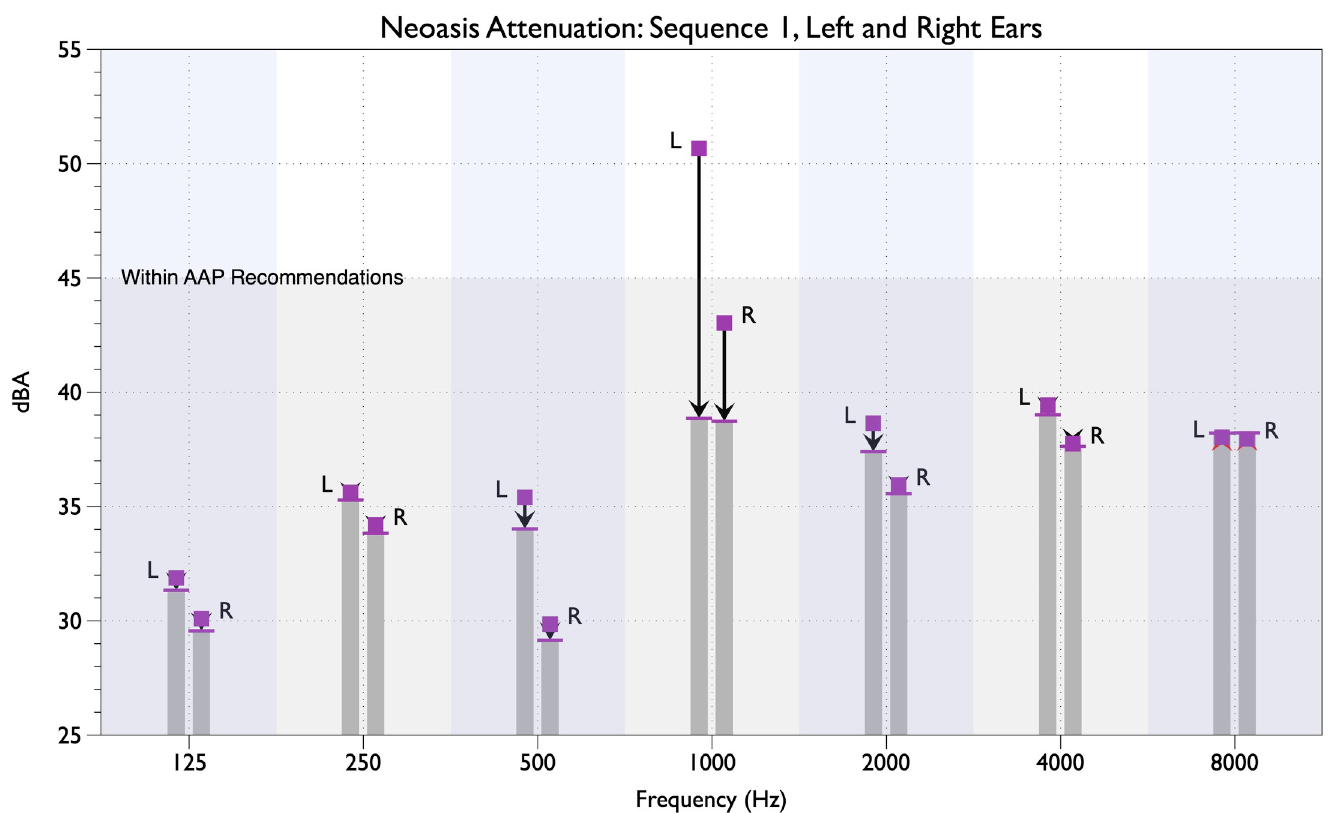
Fig 3. Noise attenuation for noise sequence 1 for both ears and seven octave bands. The unattenuated SPL is indicaterd by the square mark and the attenuated SPL is indicated by the bar at the top of the column. Measurements for the left and right ears are indicated by the letters “L” and “R,” respectively. The shaded region on the lower portion of the graph indicates the level of the AAP guideline recommendations. The vertical shaded regions indicate each octave band.